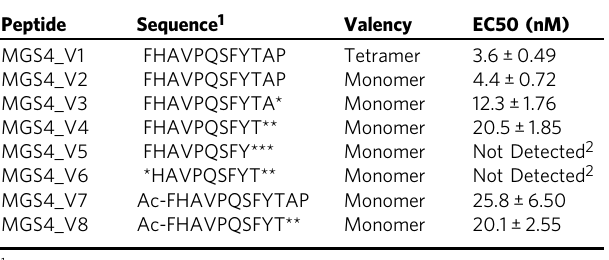
Table 1 EC50 for MGS4 peptide variants.